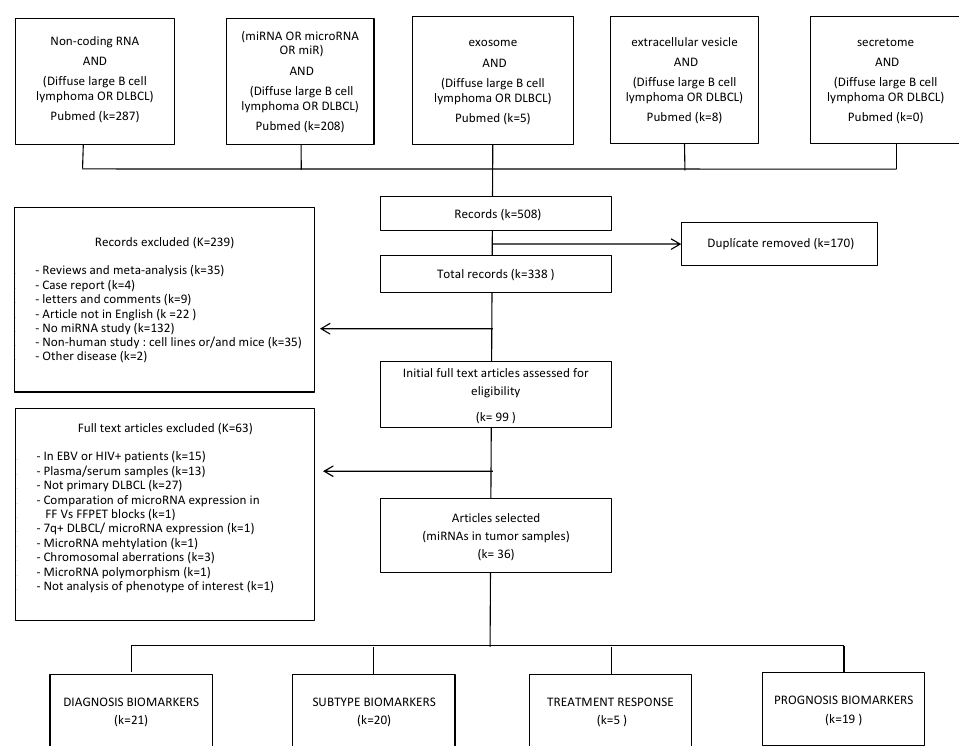
Figure 1. Flow-chart diagram of study selection. k = number of records.